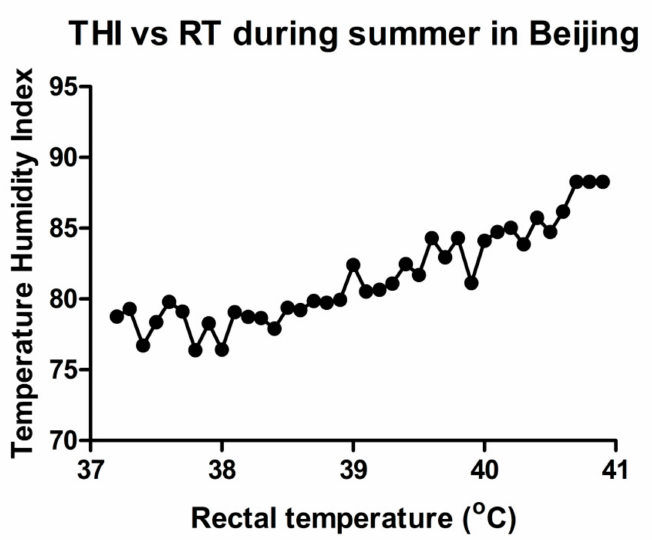
Figure 1. The temperature humidity index can a ff ect rectal temperature (RT): Evaluation of change in RT with an increase in percent temperature humidity index (%